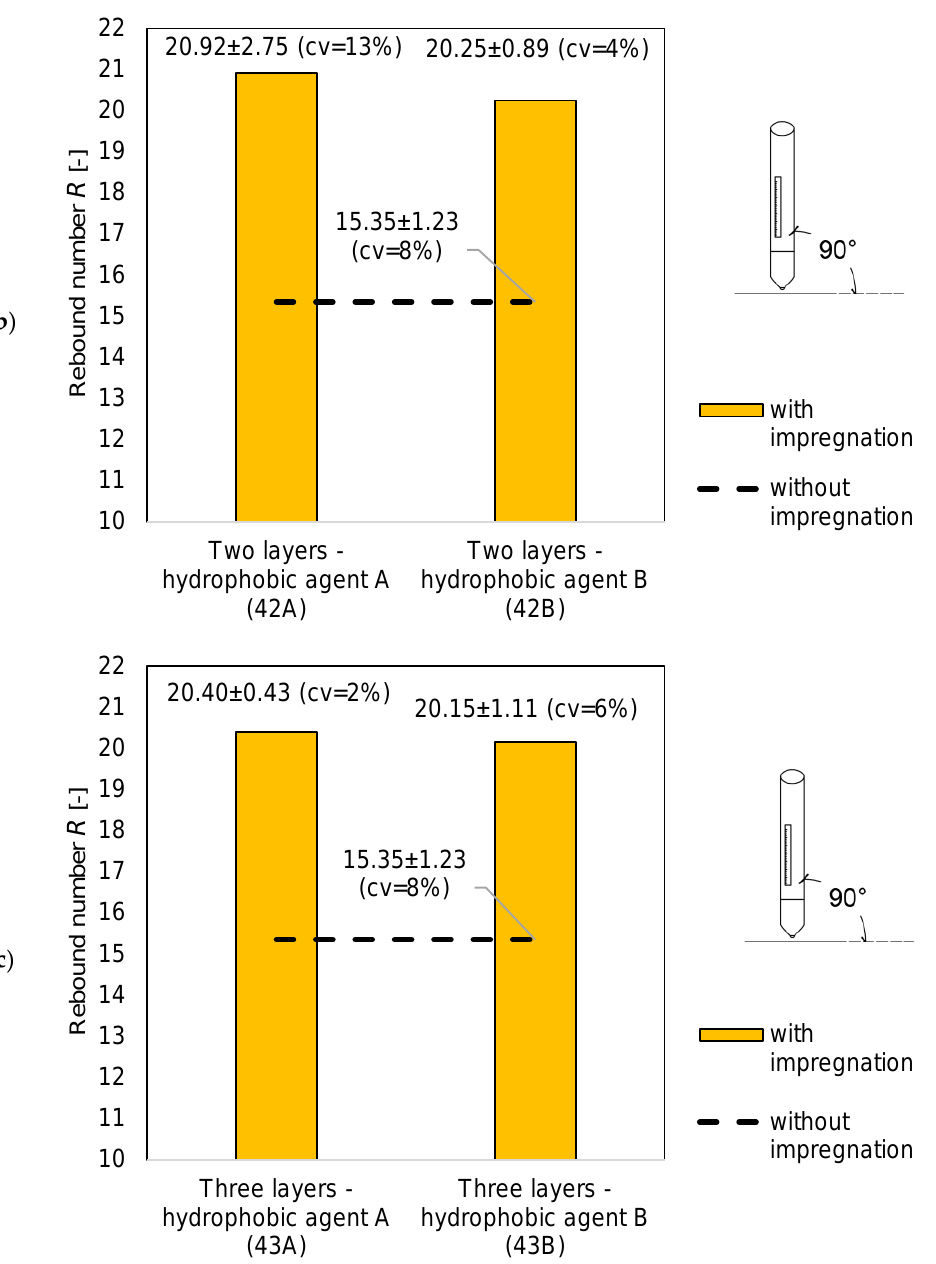
Figure 3. Comparison of the average rebound number for the samples with w/c = 0.4: ( a ) without impregnation and with one layer of the hydrophobic agent; ( b ) without impregnation and with two layers of the hydrophobic agent; and ( c ) without impregnation and with three layers of the hydrophobic agent.